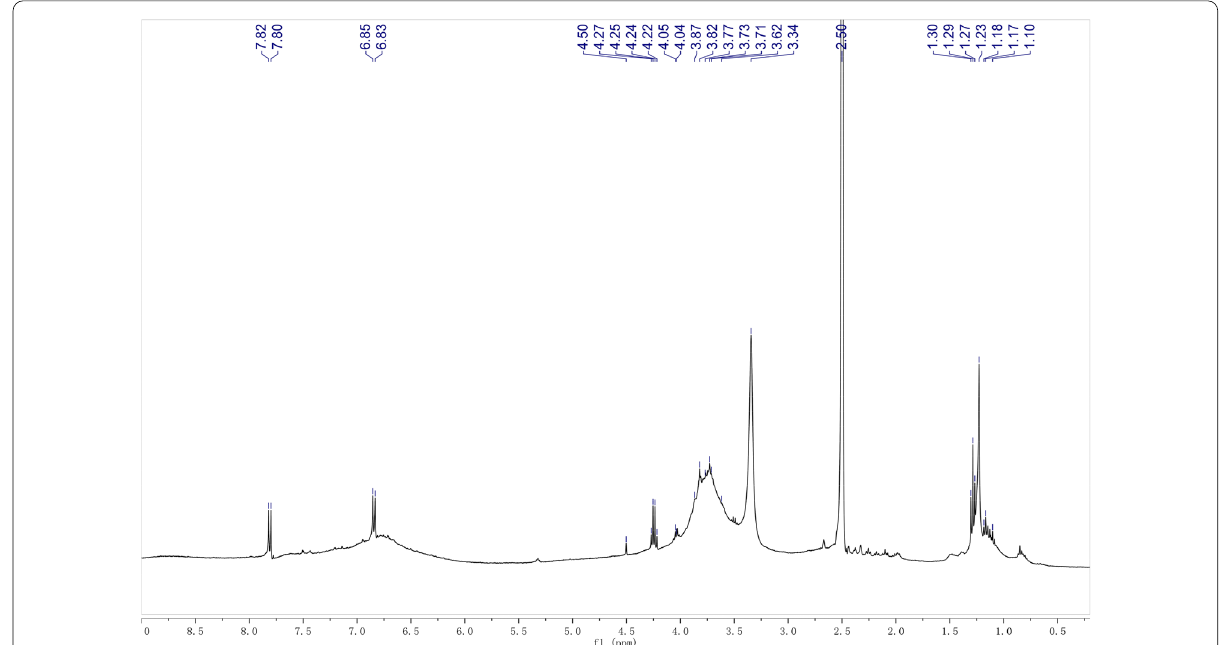
Fig. 12 1 H-NMR spectrum of the lignin extracted from palm fibers using